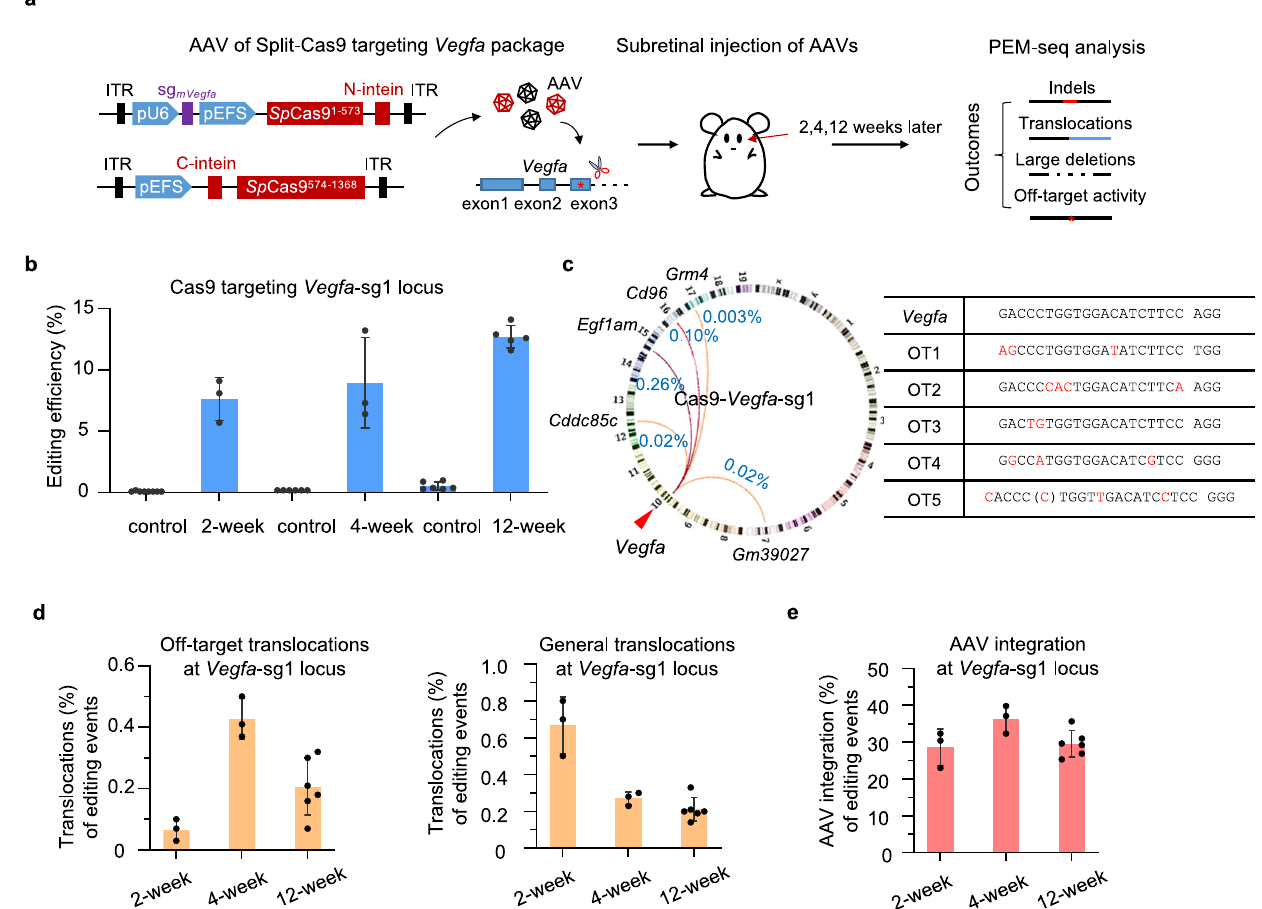
Fig. 1 | Chromatin structural variations during in vivo genome editing. a Schematics for assessing chromosomal structural variations induced by dual- AAV-delivered Sp Cas9inthemouseeye. b Editingef fi ciencyfor Vegfa -sg1inmouse eye at 2-, 4- and 12-weeks post-transfection detected by PEM-seq. Error bars, mean±SD(For2-,4-,and12-weekspost-PBSinjectionmice, n =8,6,6,respectively; for 2-, 4-, and 12-weeks post-AAV injection mice, n =3, 3, 5, respectively). c Circos plot indicating translocations among on-target and off-targets of Vegfa -sg1 in mouse eye detected by PEM-seq. DNA sequences for on-target and off-targets of